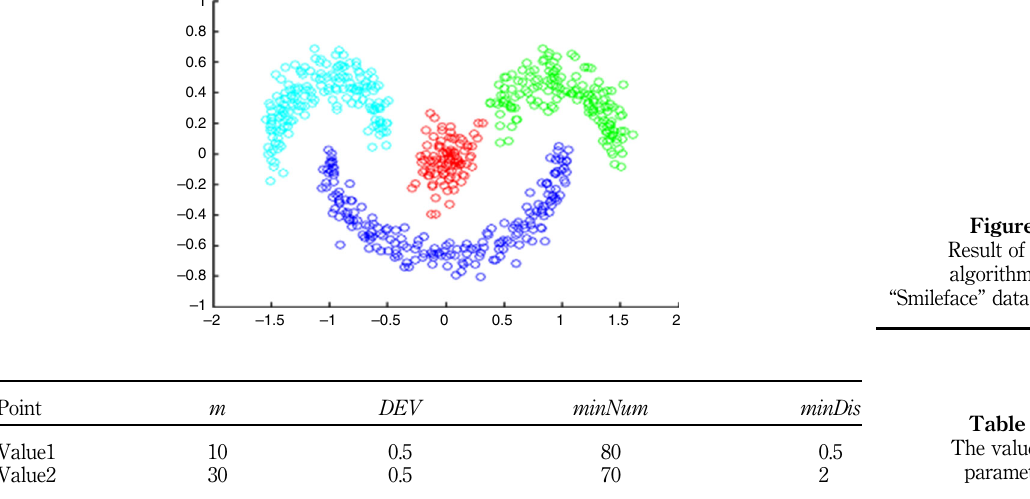
Figure 7. Result of our algorithm on “ Smileface ” data set